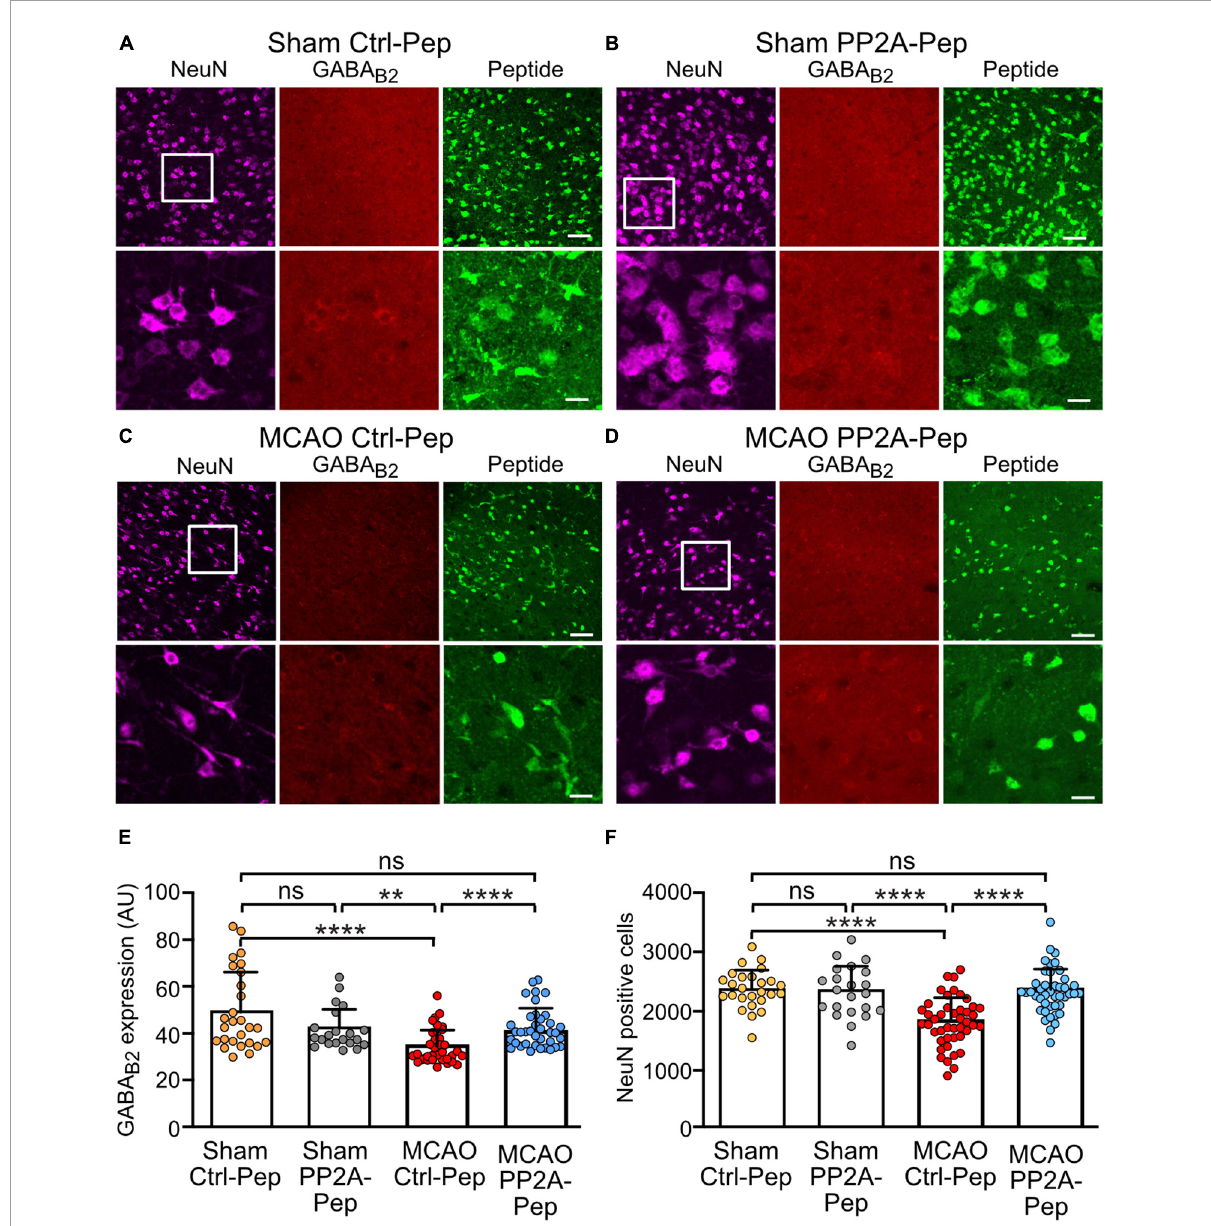
FIGURE7 PP2A-Pep normalized receptor expression and inhibited neuronal death after MCAO-induced cerebral ischemia. Brain slices containing the somatosensory cortex were prepared from sham and MCAO operated mice and incubated for 6 h with 10 µ g/ml PP2A-Pep followed by staining for GABA B receptors (red), neurons (magenta, NeuN positive cells) or PP2A-Pep (green). Representative images are shown for sections from sham operated mice treated with Ctrl-Pep (A) or PP2A-Pep (B) and for section from MCAO operated mice treated with Ctrl-Pep (C) or PP2A-Pep (D) . Images on top of each panel are of low magnification (scale bar: 40 µ m) and those on the bottom are of higher magnification (scale bars 10 µ m). (E) Quantification of GABA B receptor expression. The data represent the mean ± SD of 21–37 frames (fields of view) derived from 4 to 5 mice per condition. Two-way ANOVA with Tukey’s multiple comparison test (ns, p > 0.05, ** p < 0.005, **** p < 0.0001). (F) Quantification of neuronal loss. The data represent the mean ± SD of 22–44 frames (fields of view) derived from 4 to 6 mice per condition. Two-way ANOVA with Tukey’s multiple comparison test (ns, p > 0.05, **** p < 0.0001.